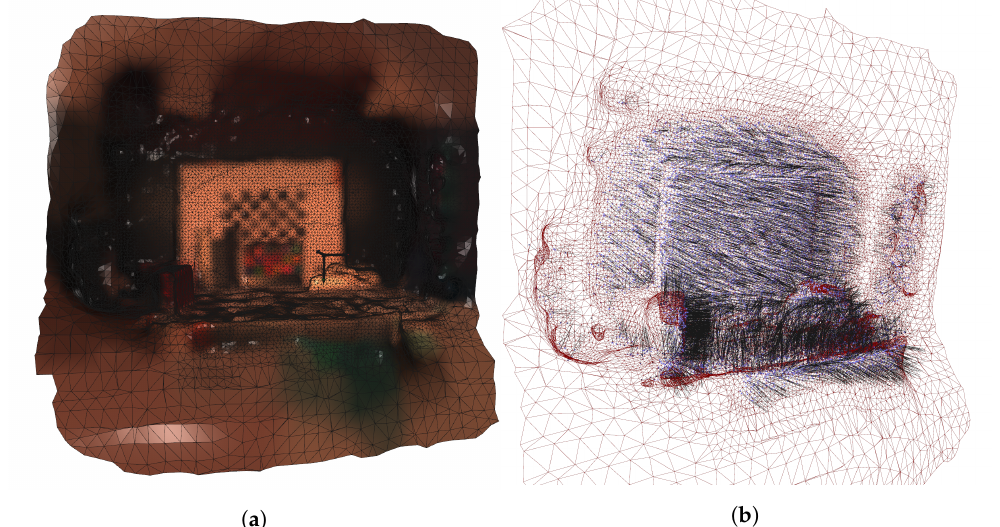
Figure 9. ( a ) The fitted mesh on the fully registered point cloud with Taubin smoothing. ( b ) Visual- ization of the mesh triangles (red) and the points point cloud (purple) with the recalculated surface normals